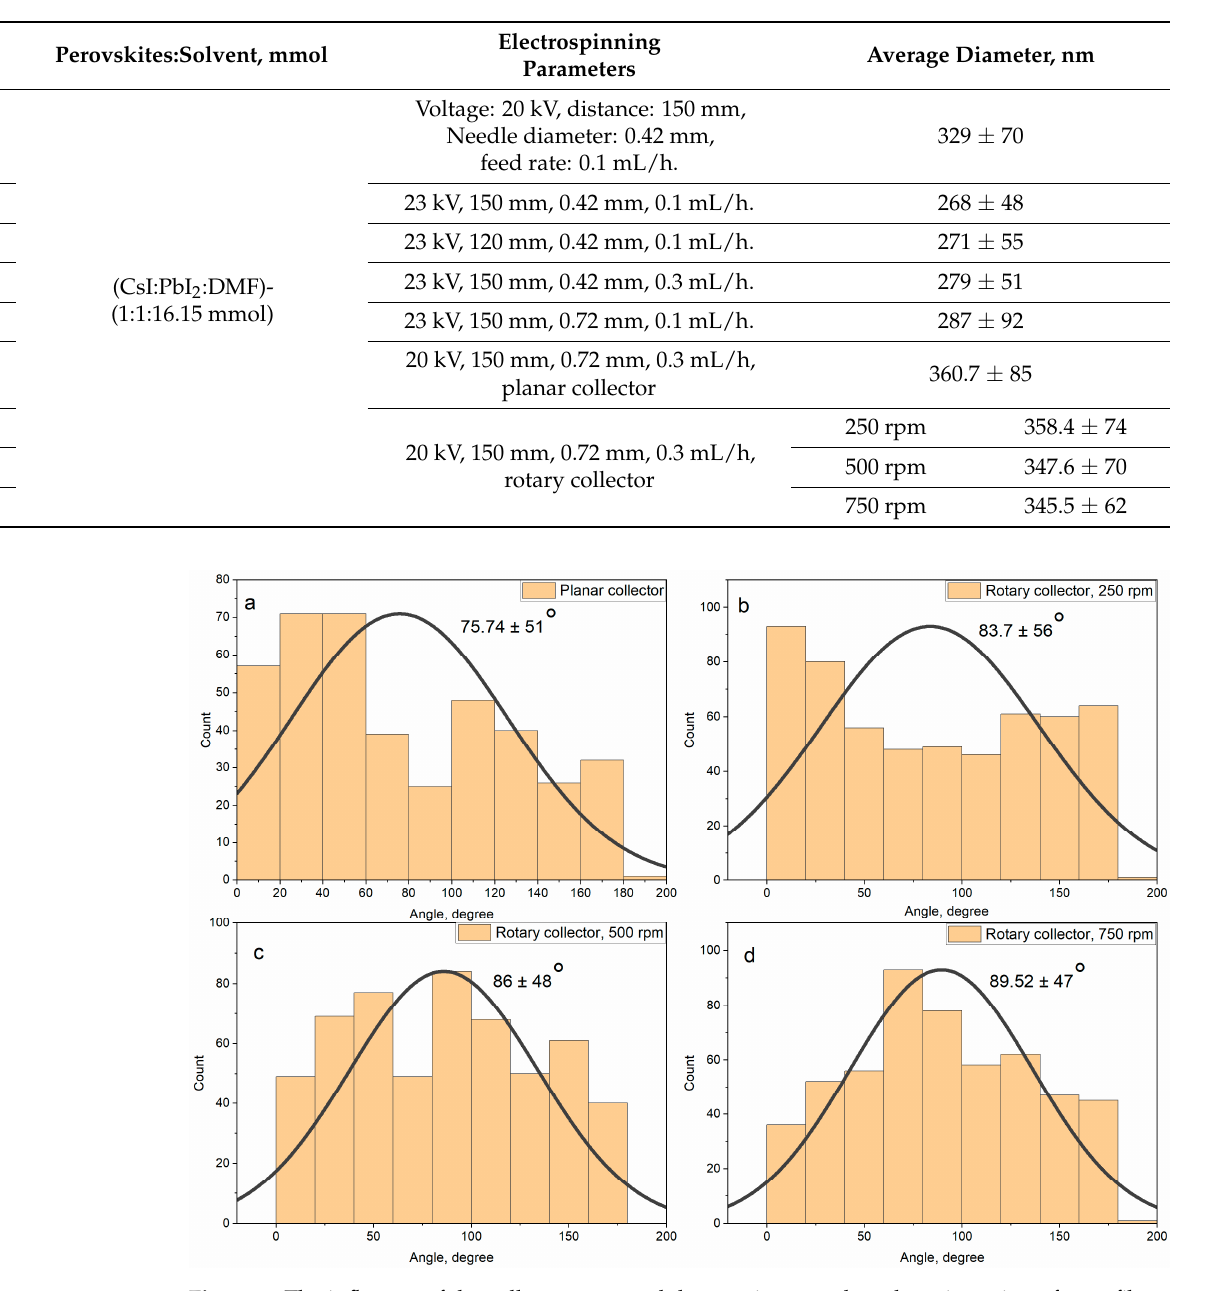
Table 1. Electrospinning parameters and the average diameter of nanofibers after annealing.